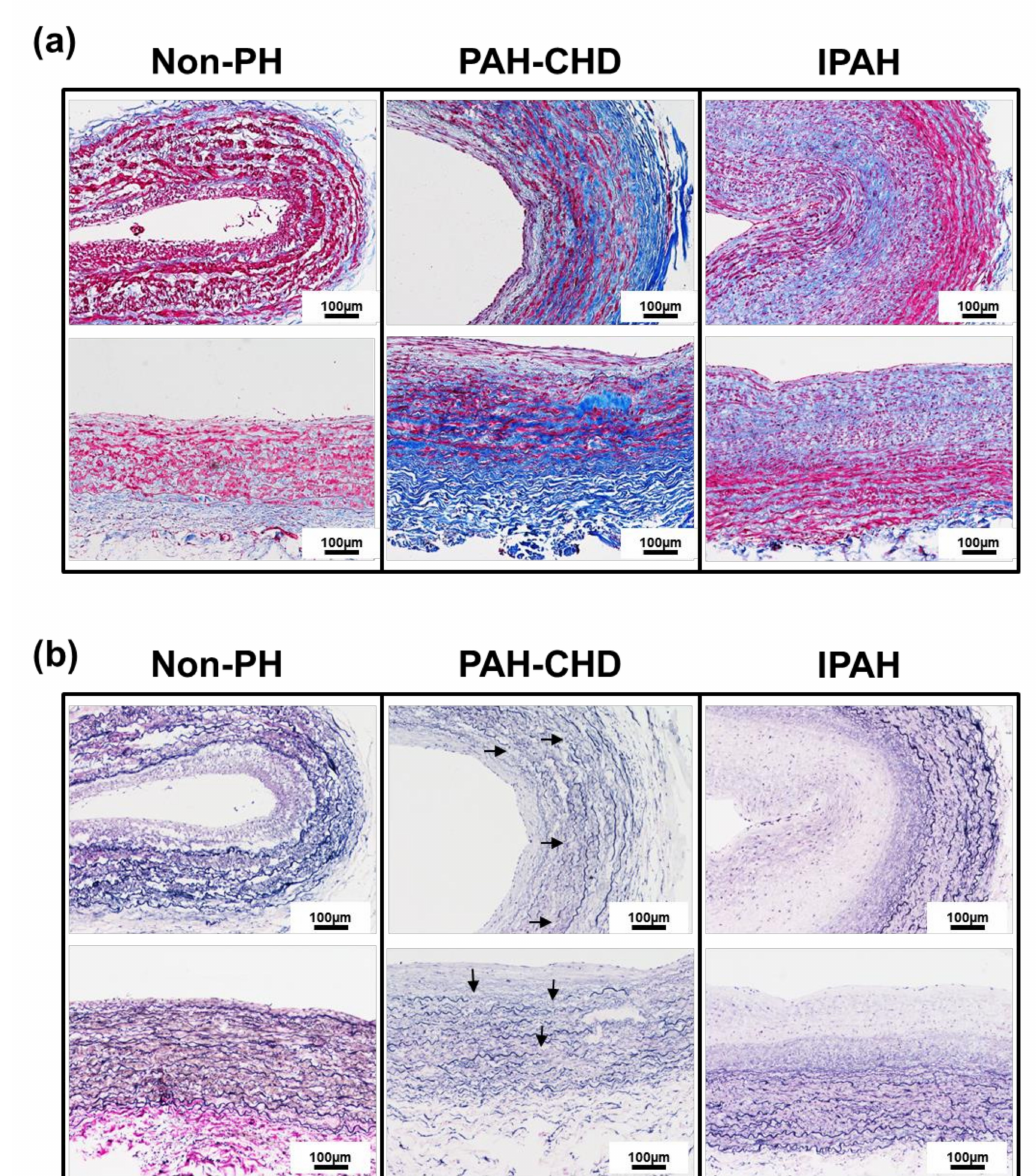
Figure 1. Collagen and elastin fiber distribution in the PAs of non-PH, PAH-CHD and IPAH patients. ( a ) Representative the Masson’s trichrome collagen staining in the pulmonary arteries PAs from the non-PH, PAH-CHD and IPAH patientpatients. The collagen content in the PA tissue from a PAH-CHD patient was significantly increased in the medial and adventitial layers compared with that in tissues from IPAH and non-PH patients. ( b ) Representative modified Verhoe ff elastin-stained PAs in these three groups. Internal and external elastic laminae (black staining) are apparent in the non-PAH PA patient, but loss of elastin and fragmentation (arrows) are observed in the PAH-CHD patient (Scale bar: 100 µ